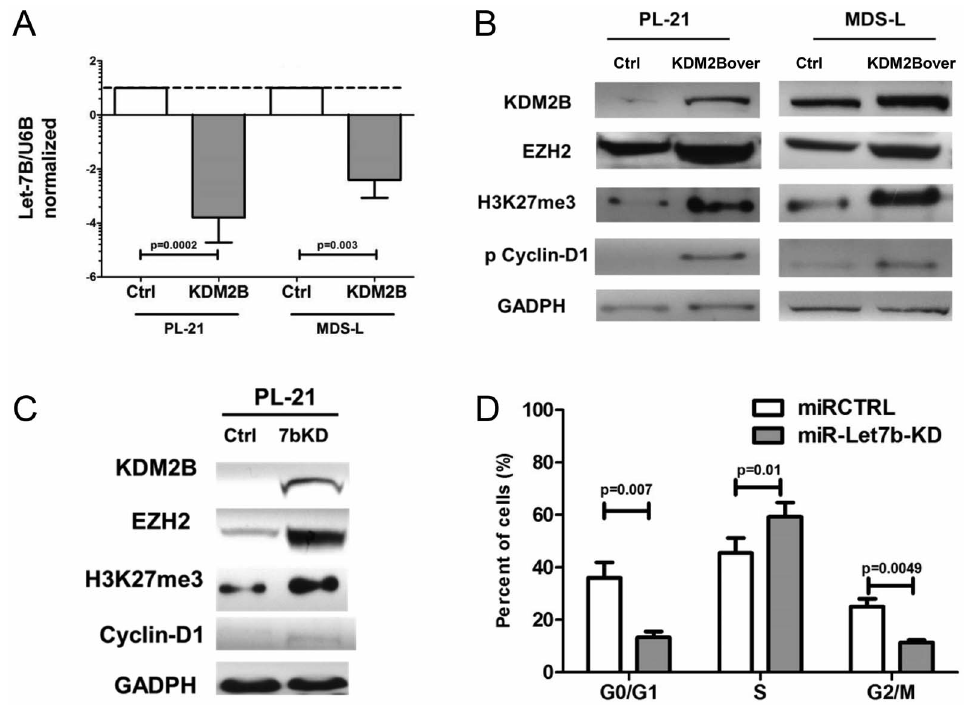
Figure 3. Effects of Let7b knockdown and KDM2B overexpression in myeloid cell lines. Overexpression of KDM2B in PL-21 and MDS-L cells resulted in decreased expression of let-7b ( A ) compared to controls (Ctrl; p=0.0002 and 0.005, respectively, U6B served as loading control, mean 6 SEM, Log 2 changes normalized for the expression in MDS-L cells) and increased EZH2, H3K27me3 and pCyclin-D1 proteins. ( B ) (GADPH served as control). The blots show one of 3 similar experiments. C ) Knockdown of let-7b in PL-21 cells resulted in increased expression of KDM2B, EZH2, H3K27me3 and, to a lesser extent, cyclin-D1. The blots show one of 3 similar experiments. D ) Knockdown of let-7b in PL-21 cells resulted in increased BrdU uptake/proliferation (increase of cells in S phase; p=0.01 and a decrease of cells in G1 and G2; p=0.007 and p=0.005, respectively; mean 6 SEM of 3 experiments; Student’s t-test for comparison of continuous variables).